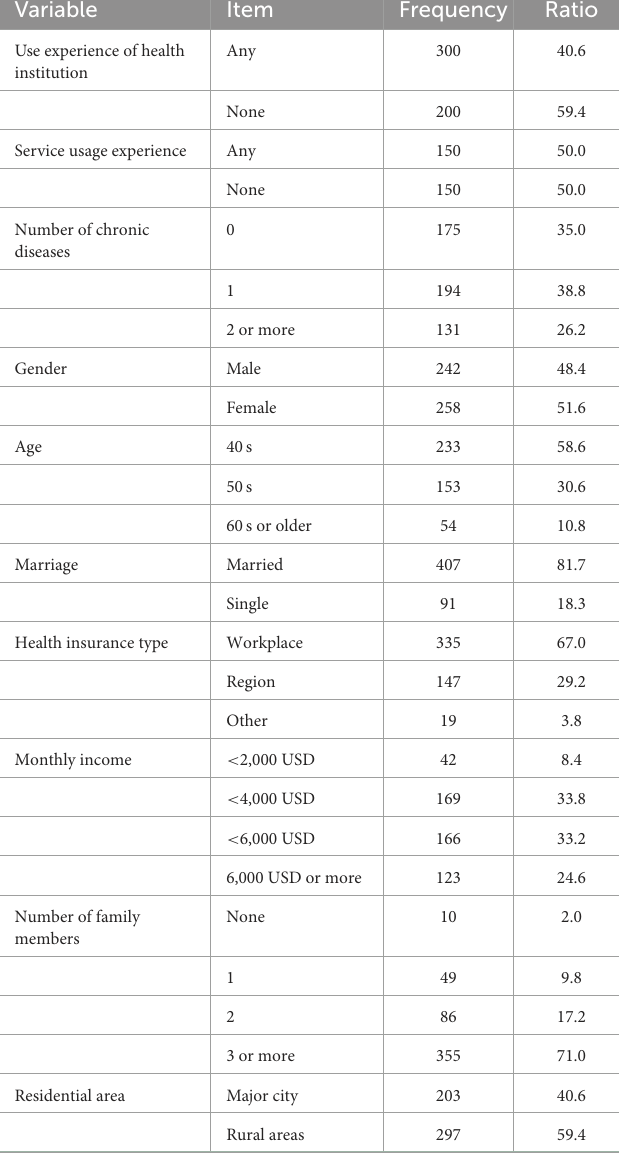
TABLE 2 Sociodemographic characteristics of study participants (unit: Person, %).